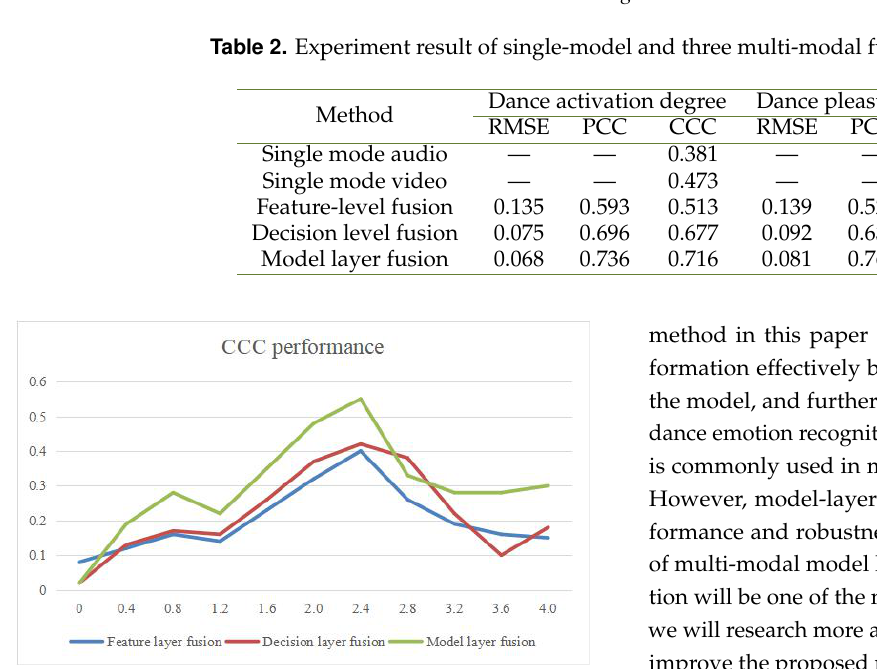
Fig. 7. Visualization of sentiment prediction and true value of three fusion